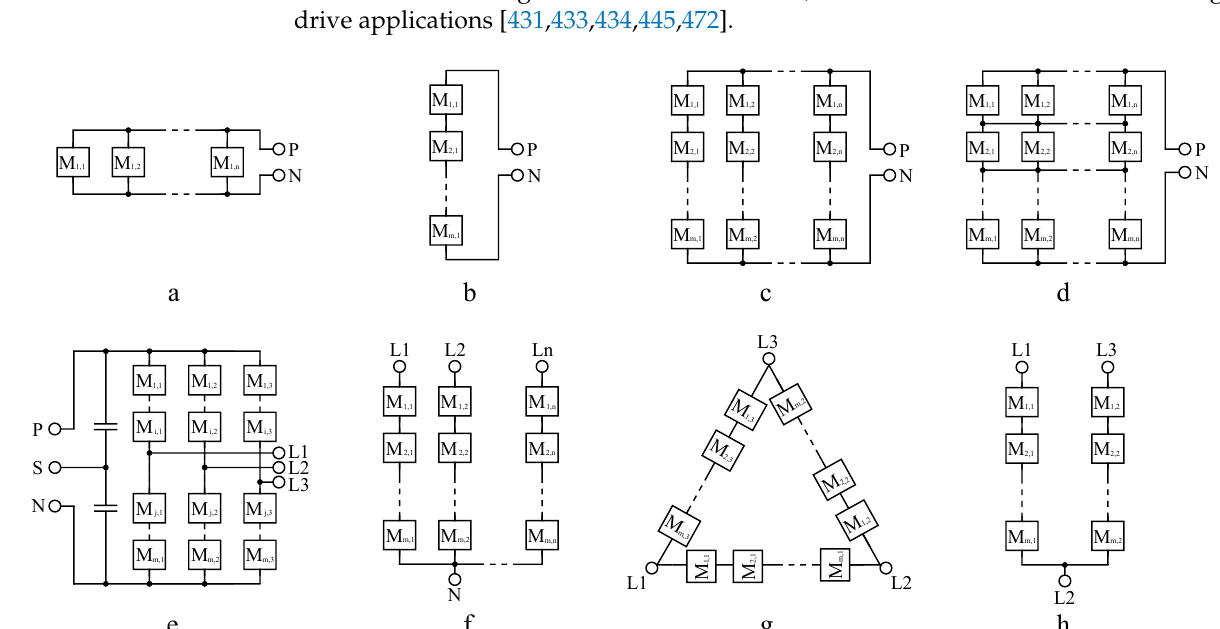
Figure 7. Schematic visualization of different macrotopologies for reconfigurable IBSs: ( a ) parallel circuit, ( b ) serial circuit, ( c ) serial parallel configuration, ( d ) parallel serial configuration, ( e ) MMC topology, ( f ) star configuration, ( g ) delta configuration, ( h ) reduced string